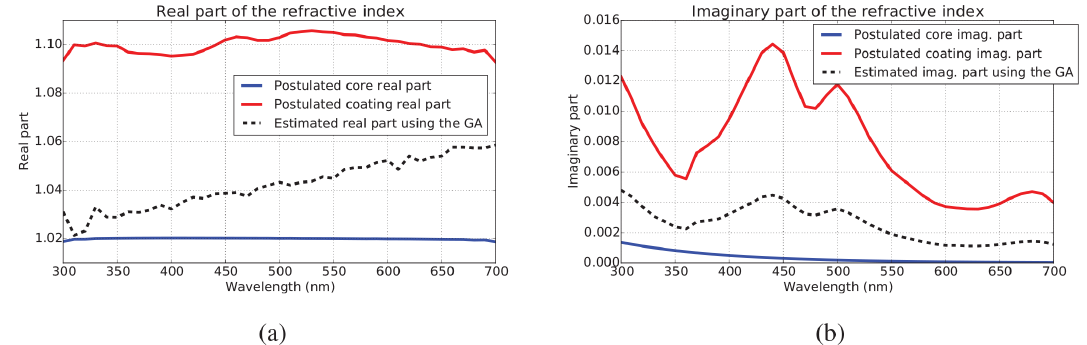
Figure 8. Postulated (a) real and (b) imaginary refractive index signatures for the inner and outer layers of spherical-shaped particles, together with the estimated (a) real and (b) imaginary refractive index signature calculated using the genetic algorithm model.